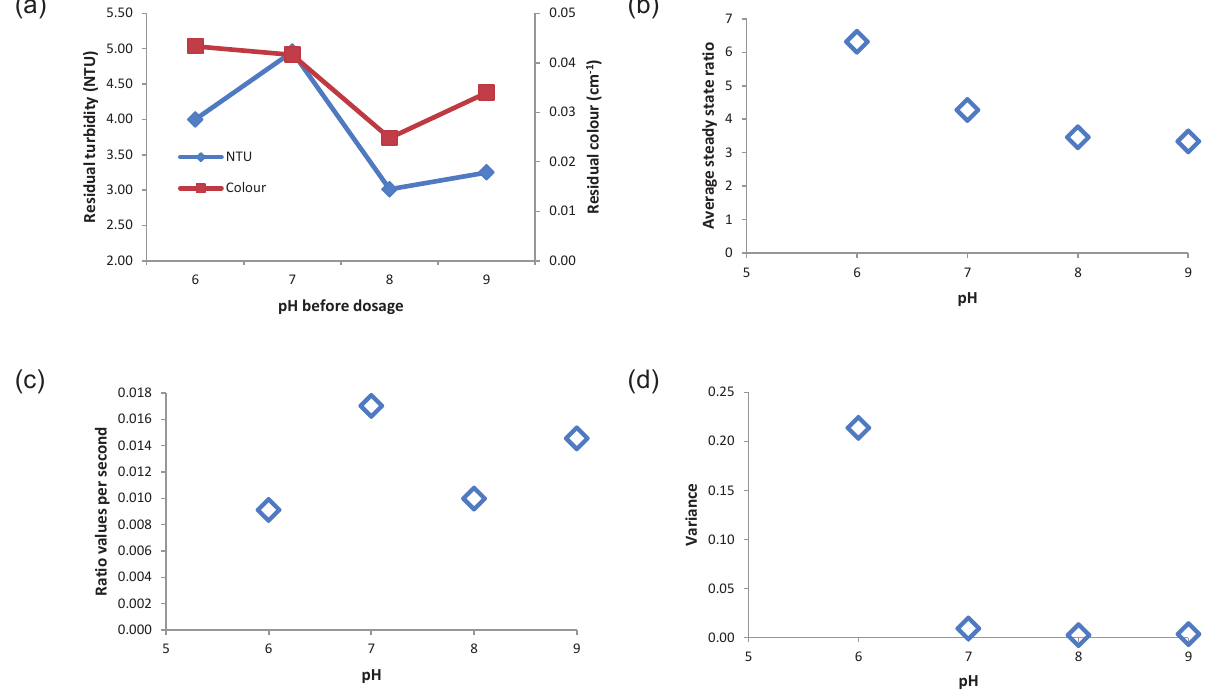
a pH of 6–7. Figure 3a indicates that the lowest residual tur- bidity and colour was observed at an initial sample pH of 8; corresponding to a coagulation pH of